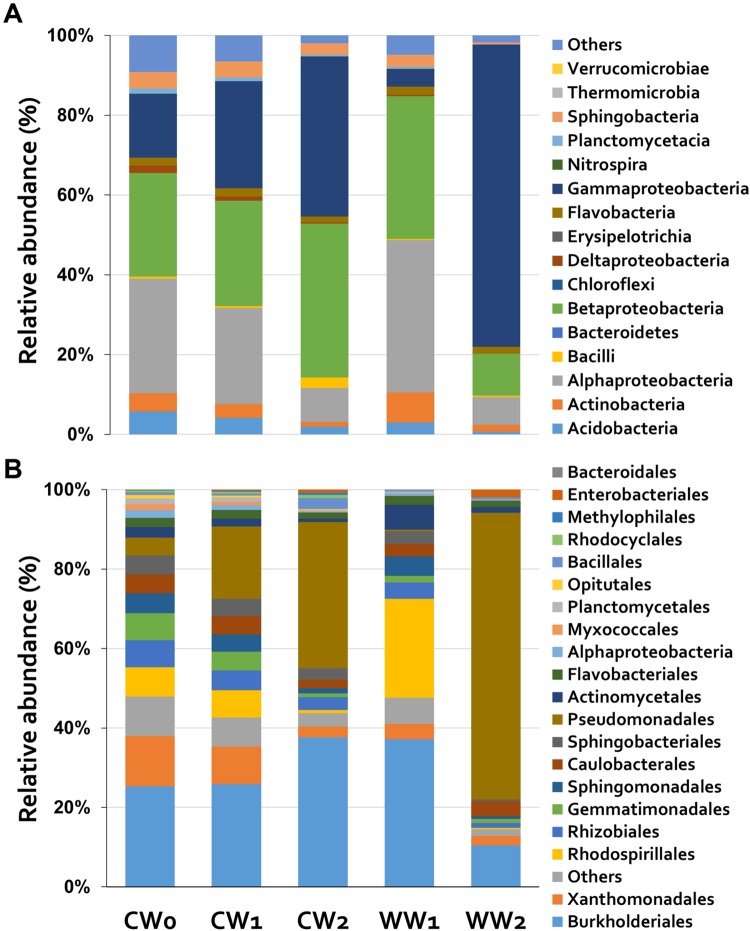
Relative abundance (%) of rhizosphere bacteria. The composition of the bacterial community in the rhizospheres of three control treatments (CW: control) and two whitefly-infested treatments (WW: Whitefly treatments). Numbers indicate exposure time to whitefly (CW0: time zero; CW1 and WW1: 1 week; CW2 and WW2: 2 weeks). The distribution of the different bacterial phyla is based on data obtained by 454 sequencing. Distribution of classes with relative abundance (>0.3% dissimilarity; A) and orders (B) in control and whitefly infestation samples.